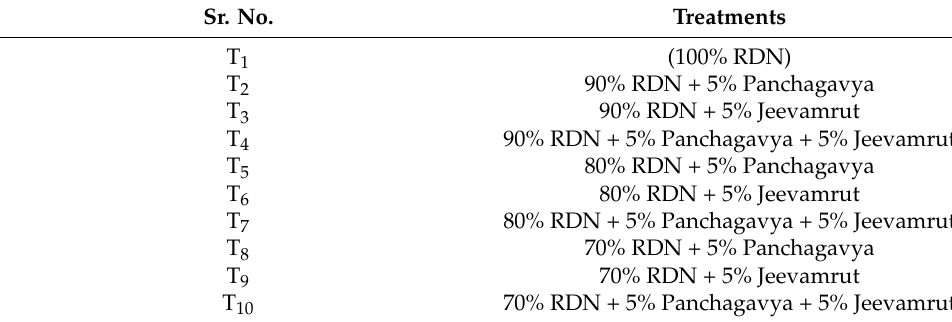
Table 1. Treatment details for the experimental field. Sr. No.